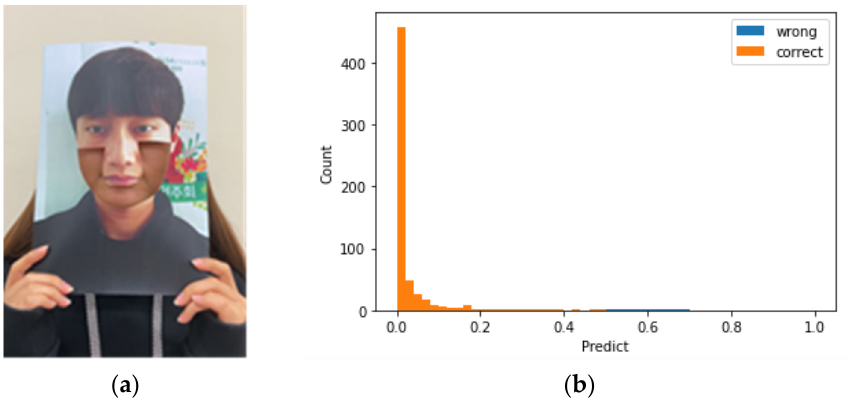
Figure 11. ( a ) Error case when fake was predicted as real. ( b ) Genuine and imposter plots for real test data in iPad mini case.